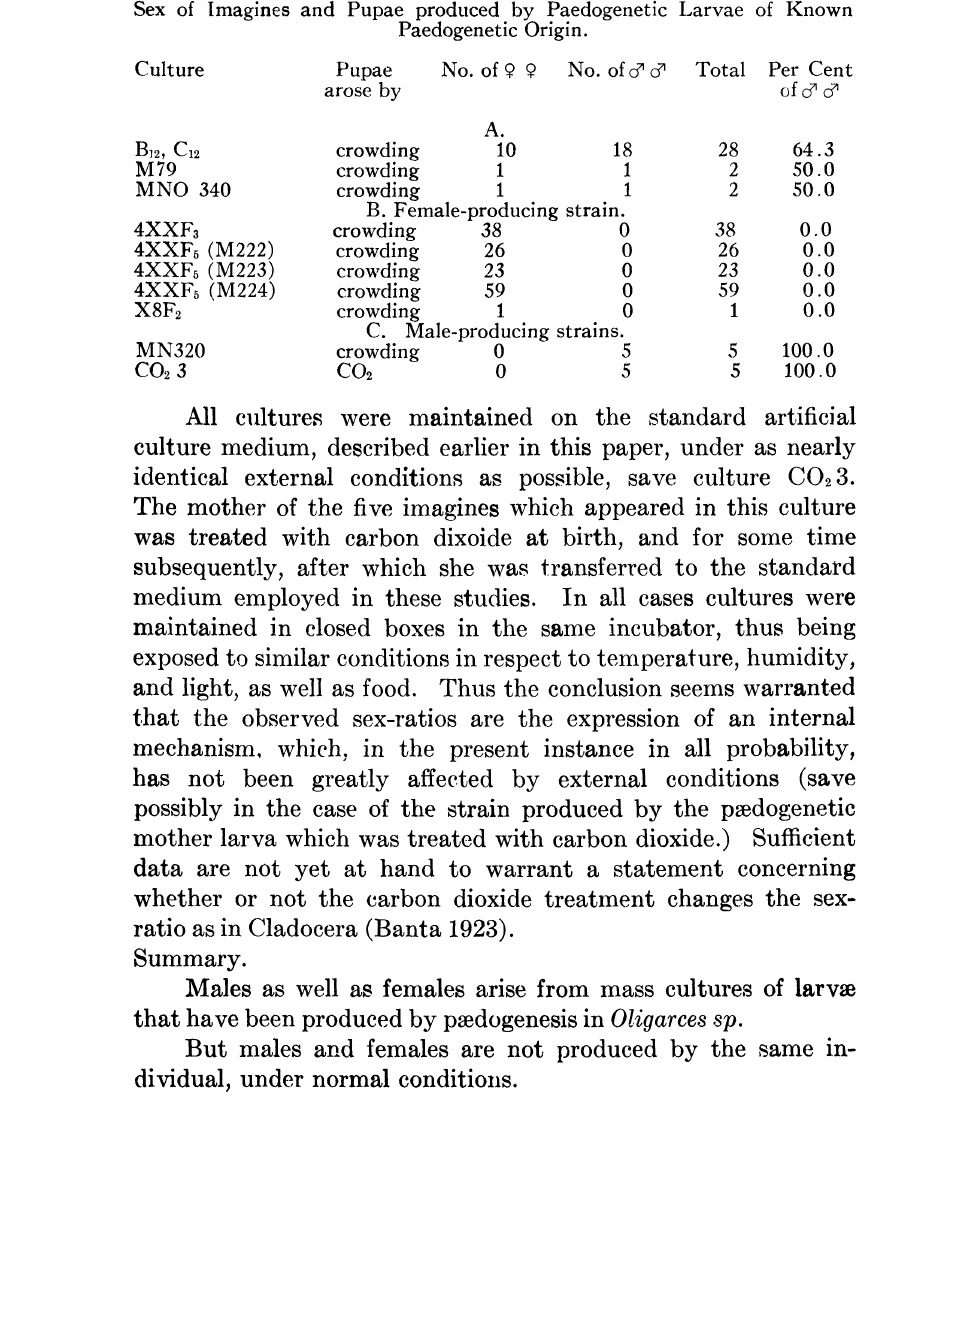
Sex of Imagines and Pupae produced by Paedogenetic Larvae of Known Paedogenetic Origin. Culture